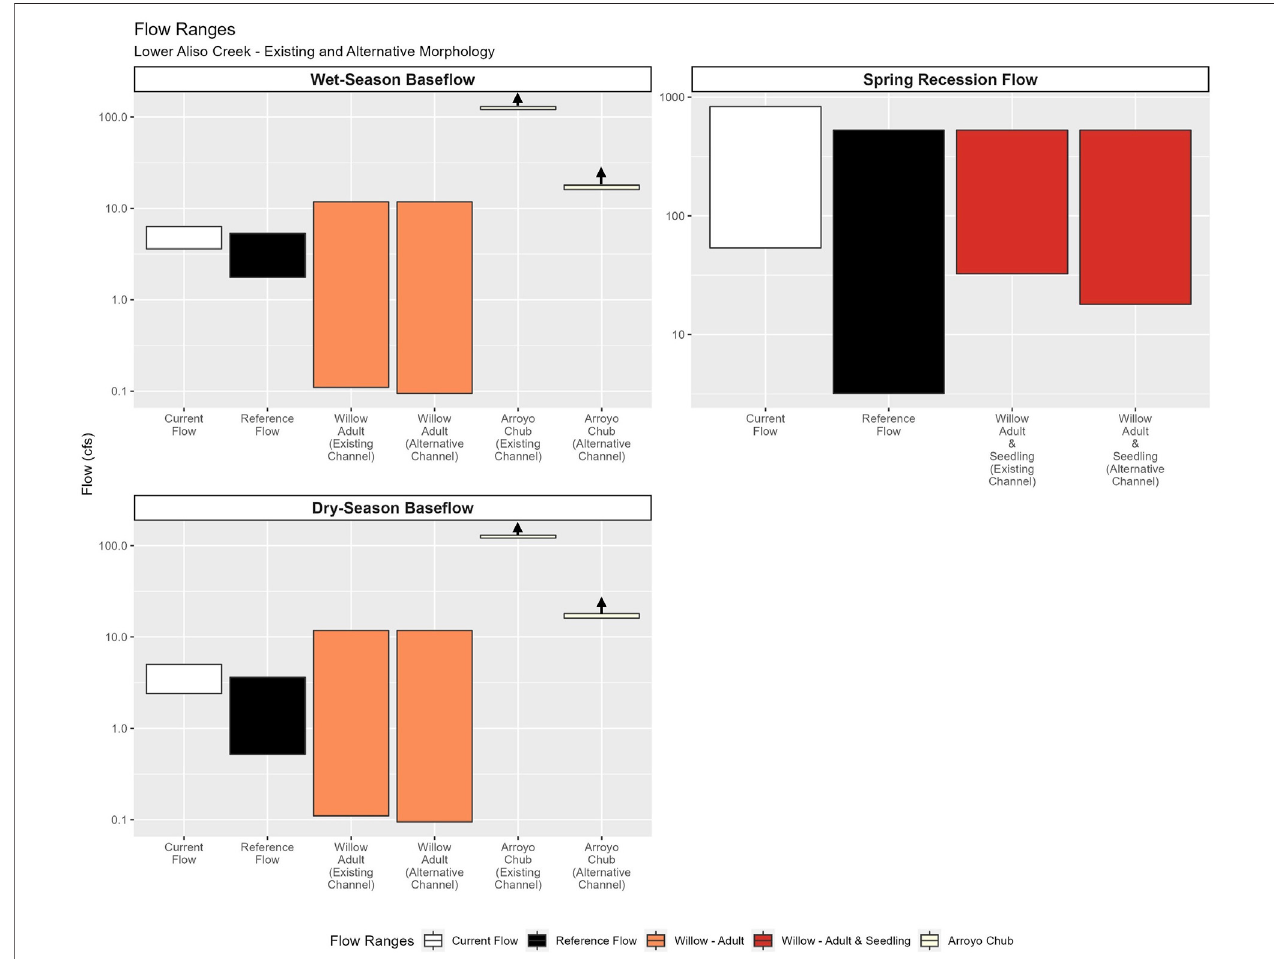
FIGURE7| Flowrangesfordry-seasonbase fl ow,springrecession fl ow,andwet-seasonbase fl owmagnitudesundercurrentandreferenceconditionsandre fi ned ecological fl owneedsforfocalspecies, willowandarroyochub,developed fortheexisting channelmorphologyand a “ restored ” alternativechanneldesign.Current fl ow conditions are suitable for willow seedling and adult under existing and alternative channel geometries but are too low for arroyo chub.